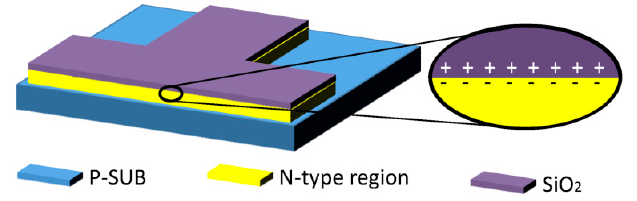
Figure 5. The surface effect on a CMOS Hall device.